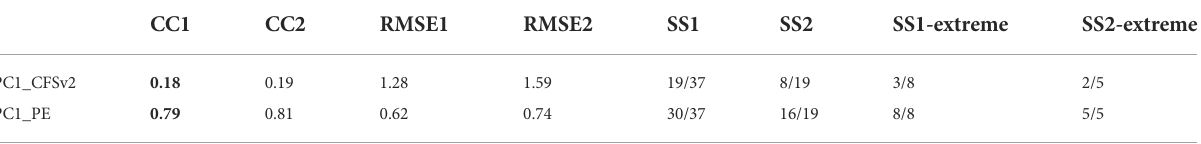
TABLE 2 Correlation coef fi cient (CC), RMSE, the rate of same signs in all years (SS) and in extreme years (SS-extreme) between PC1_obs and PC1_CFSv2 during 1982 – 2018 (CC1, RMSE1, SS1 and SS1-extreme) and during 2000 – 2018 (CC2, RMSE2, SS2 and SS2-extreme). The correlation coef fi cient(CC), RMSE,the rateofsamesigns inall years(SS)and inextremeyears(SS-extreme)between PC1_obs andPC1_PE inthe one-year-leave cross validation (CC1, RMSE1, SS1 and SS1-extreme) and in the independent hindcast (CC2, RMSE2, SS2 and SS2-extreme). The bold value denotes that the correlation coef fi cients were signi fi cant at the 99% con fi dence level based on Student ’ s t